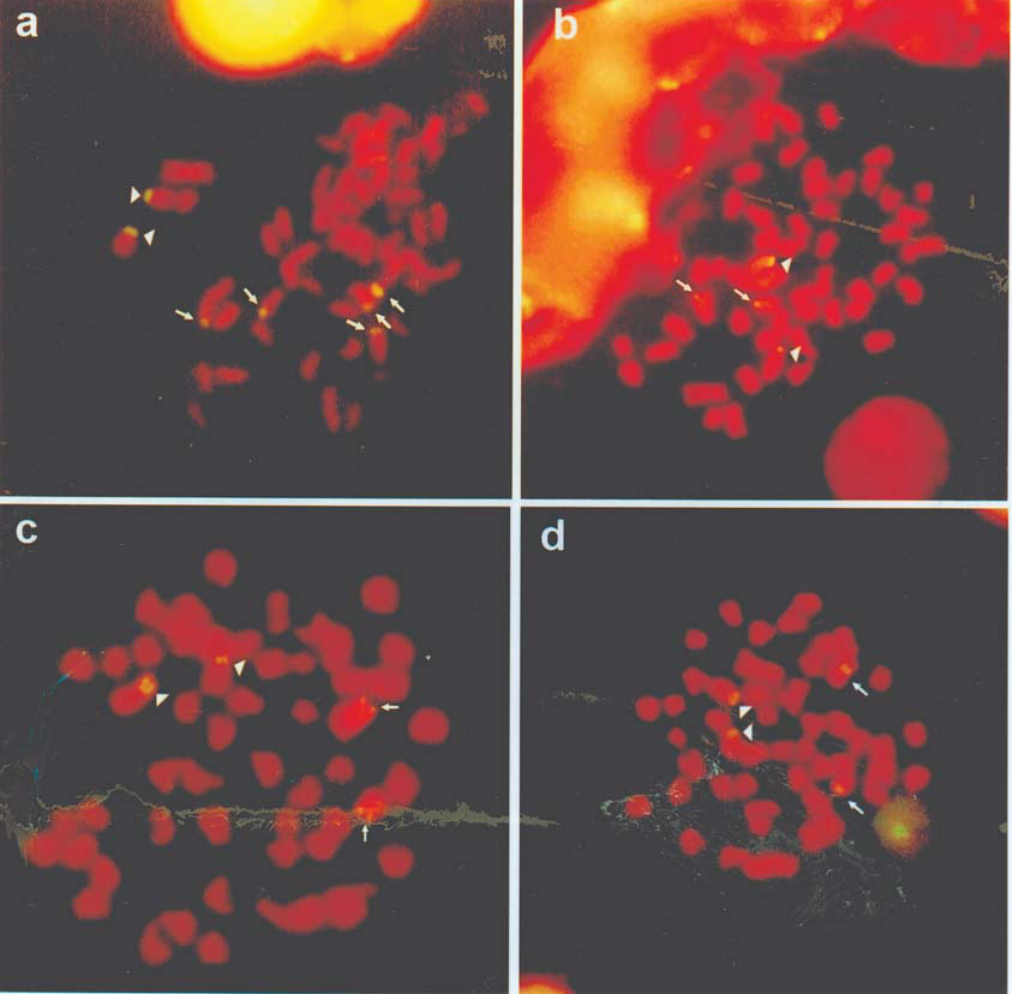
Figure 1 - Fluorescence in situ hybridization (FISH) Astyanax altiparanae metaphases showing the chromosomal location of 18S rDNA sites in popula- tions from the Keçaba stream (a), Paraná river (b), Tatupeba stream (c) and Maringá stream (d). The arrows indicate the ribosomal cistrons carrier chro- mosomes and the arrowheads the ribosomal cistrons in the short arm of 2 acrocentric chromosomes of four